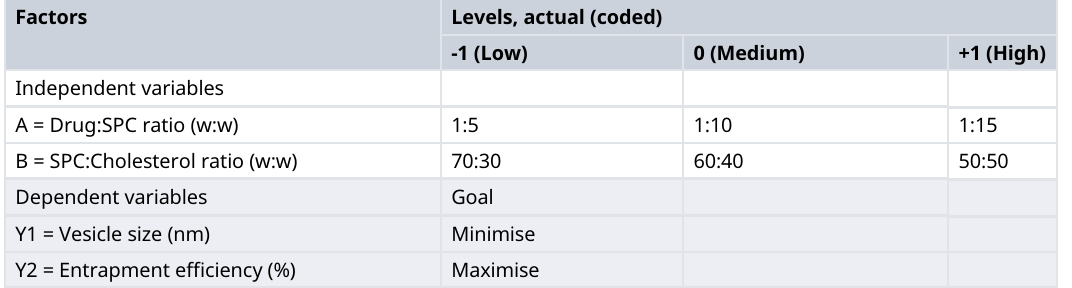
Table 1. 3 2 level factorial design variables for optimised formulation: coded levels and actual values for each factor.